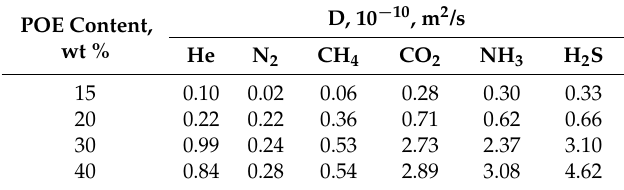
Table 2. Diffusion coefficients (D) of polymer obtained at different POE block contents.